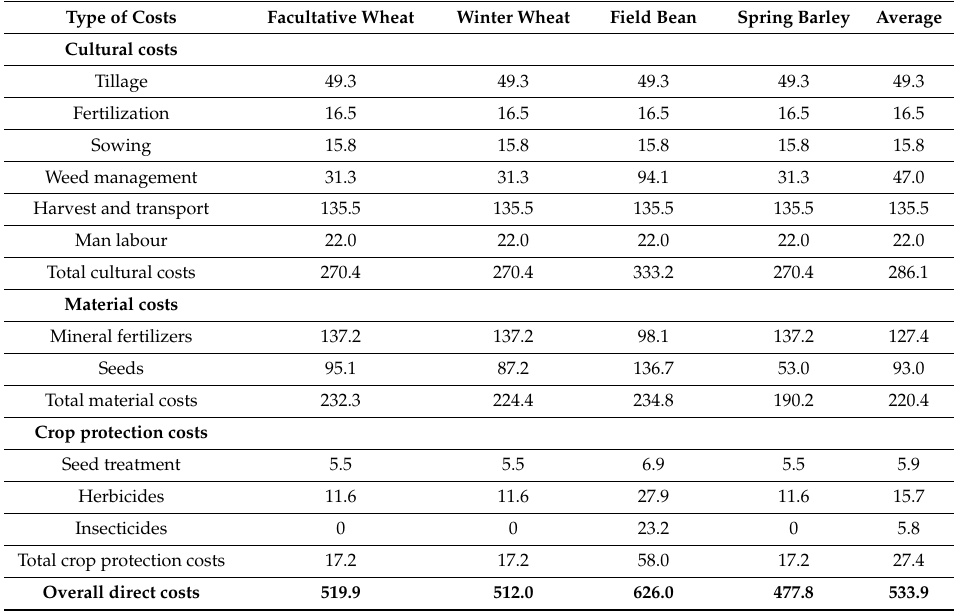
and non-LFA area.